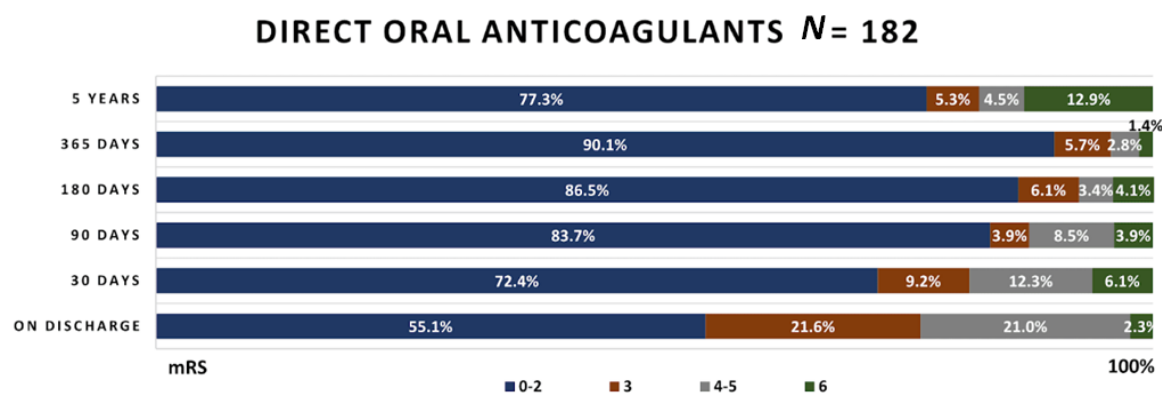
Figure 4. Functional outcome in the cardioembolic stroke patient group.